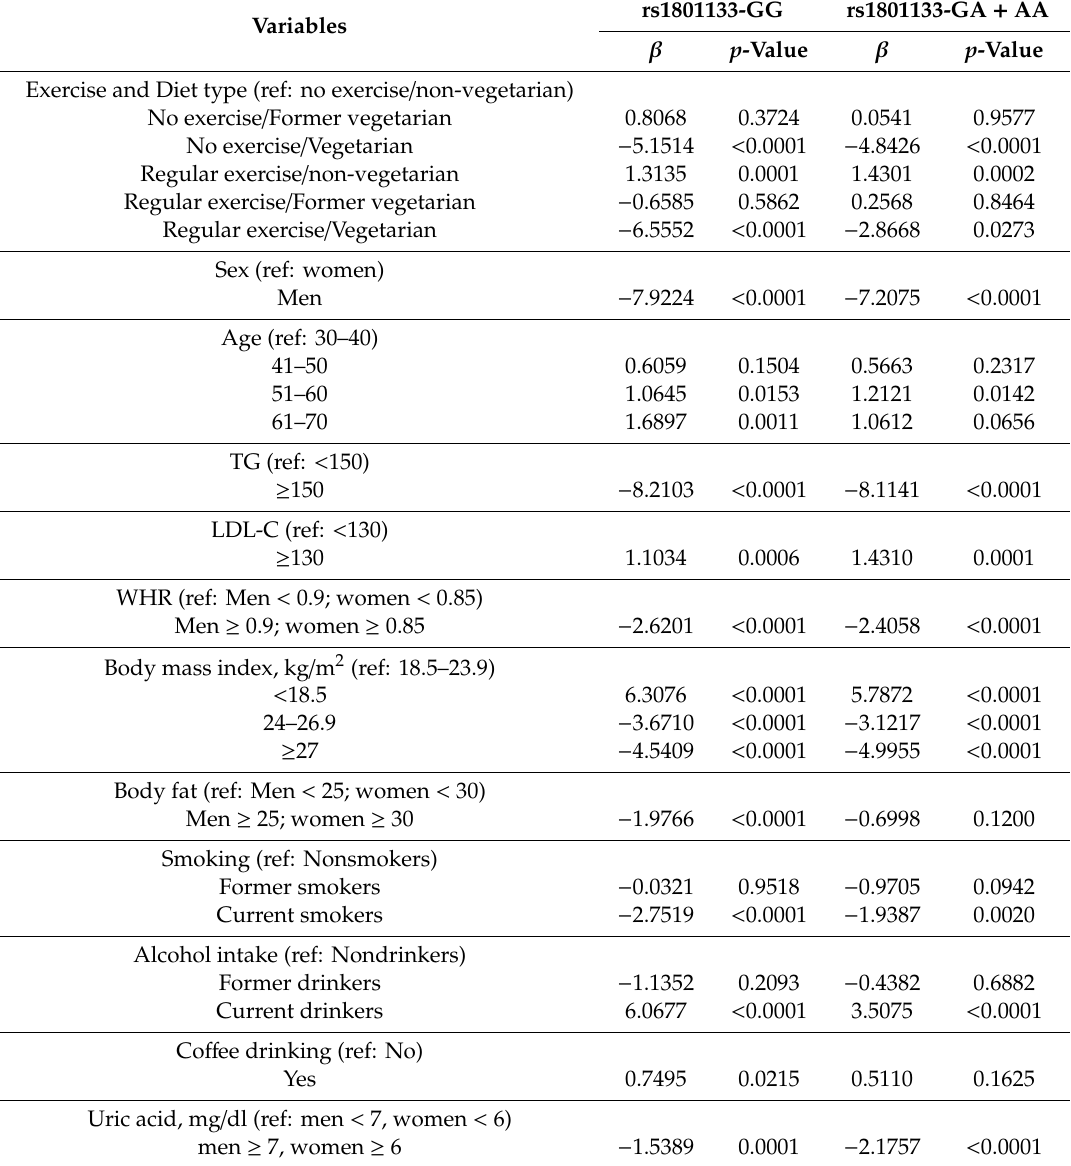
Table 4. Exercise exposure together with vegetarian diets and their association with HDL-C.